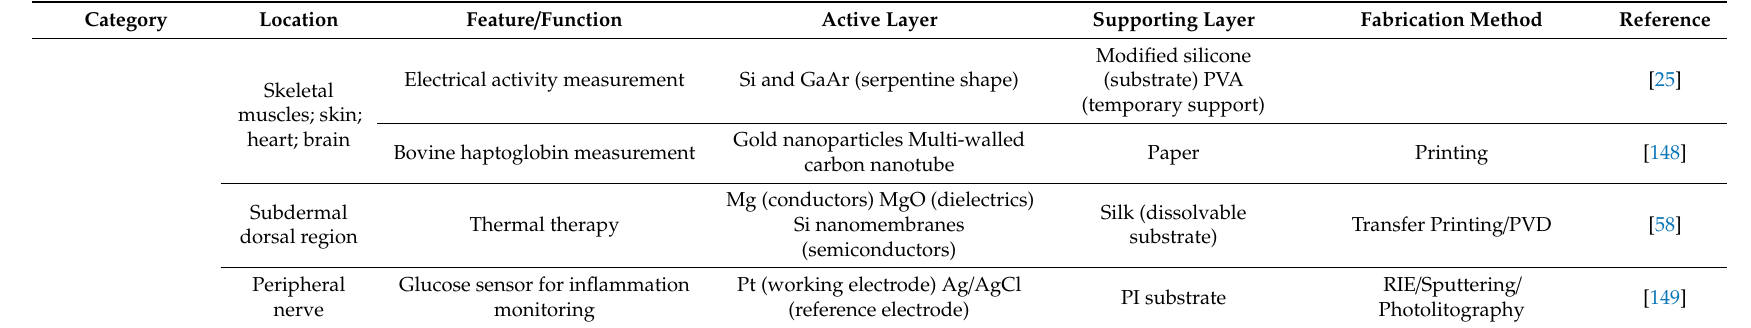
Table Legend: Si—Silicon; PI—Polyimide; PZT—Lead Zirconate Titantate; Au—Gold; PDMS—Polydimethylsiloxane; Cr—Chromium; Pt—Platinum; Ti—Titanium; Cu—Copper;